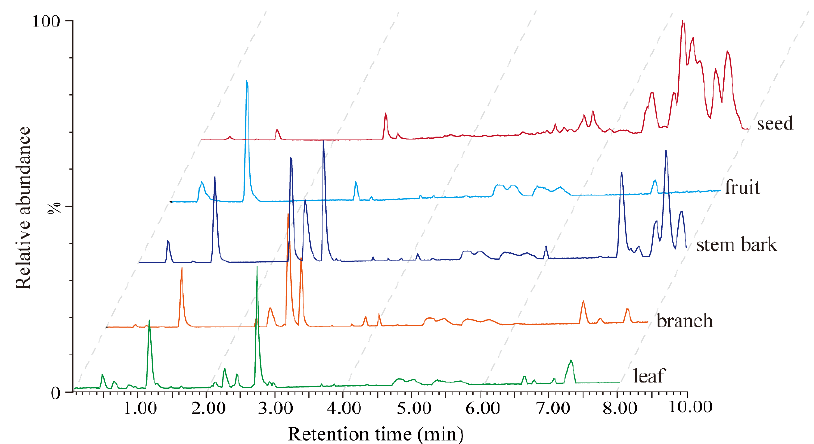
Figure 2. TIC chromatography (negative mode) of different part extracts of G. xanthochymus . The retention time and negative molecular ion peaks of the main components in the